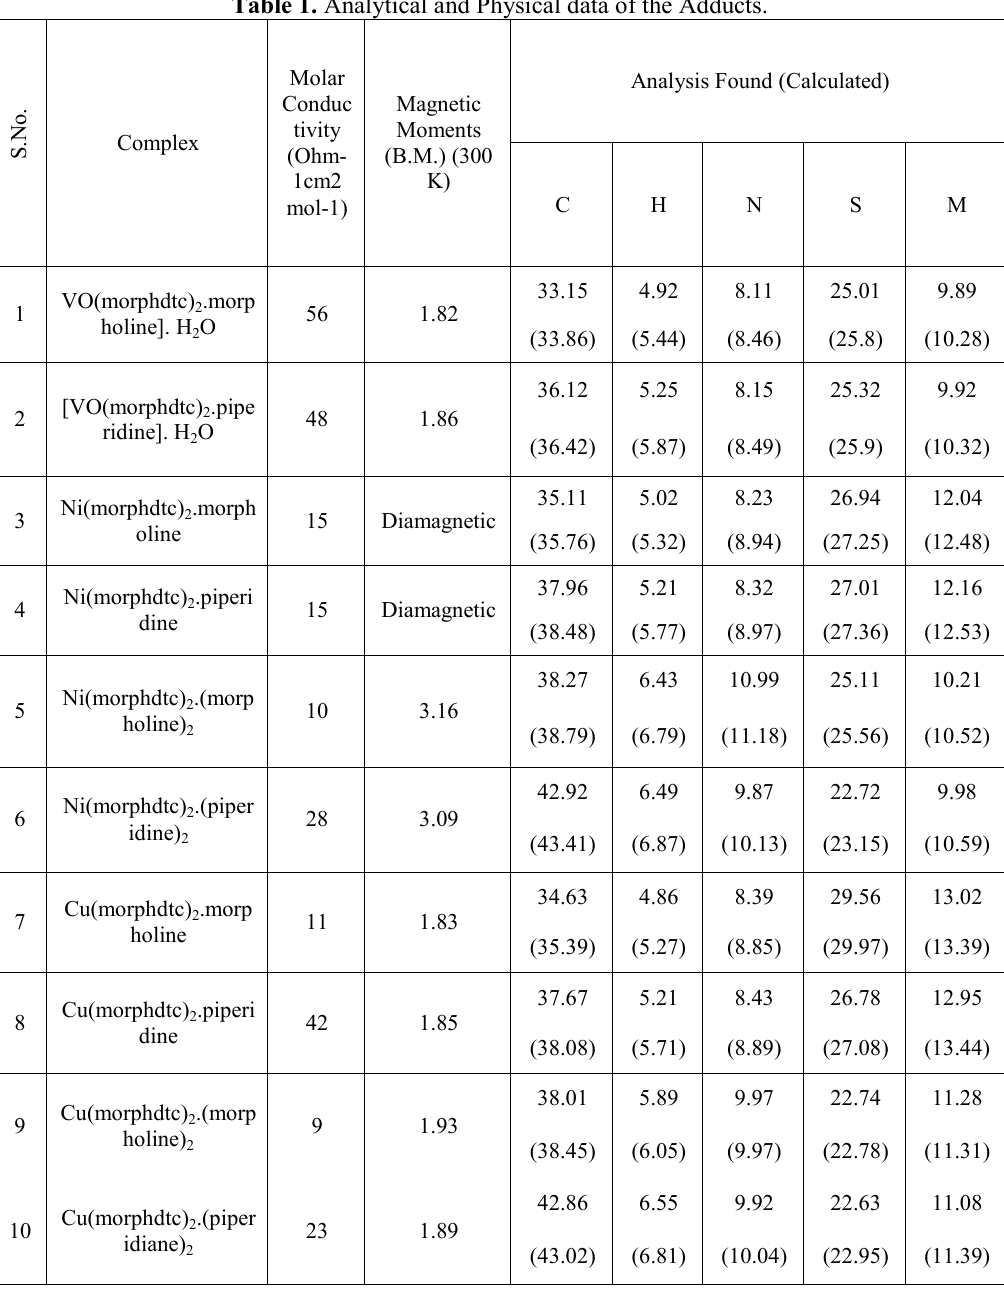
Table 1. Analytical and Physical data of the